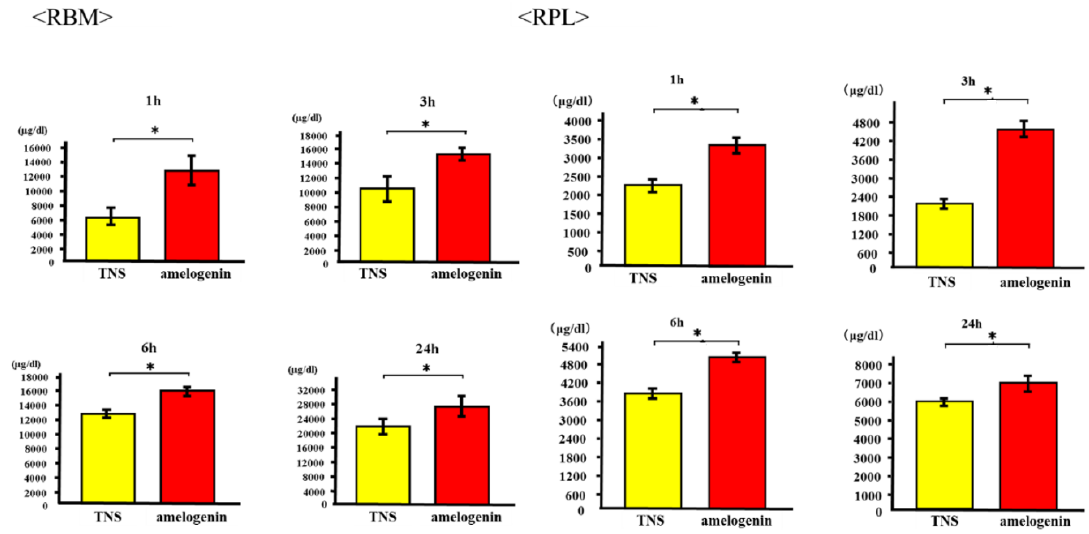
Figure 7. Cell adhesion in control and test groups. * p <